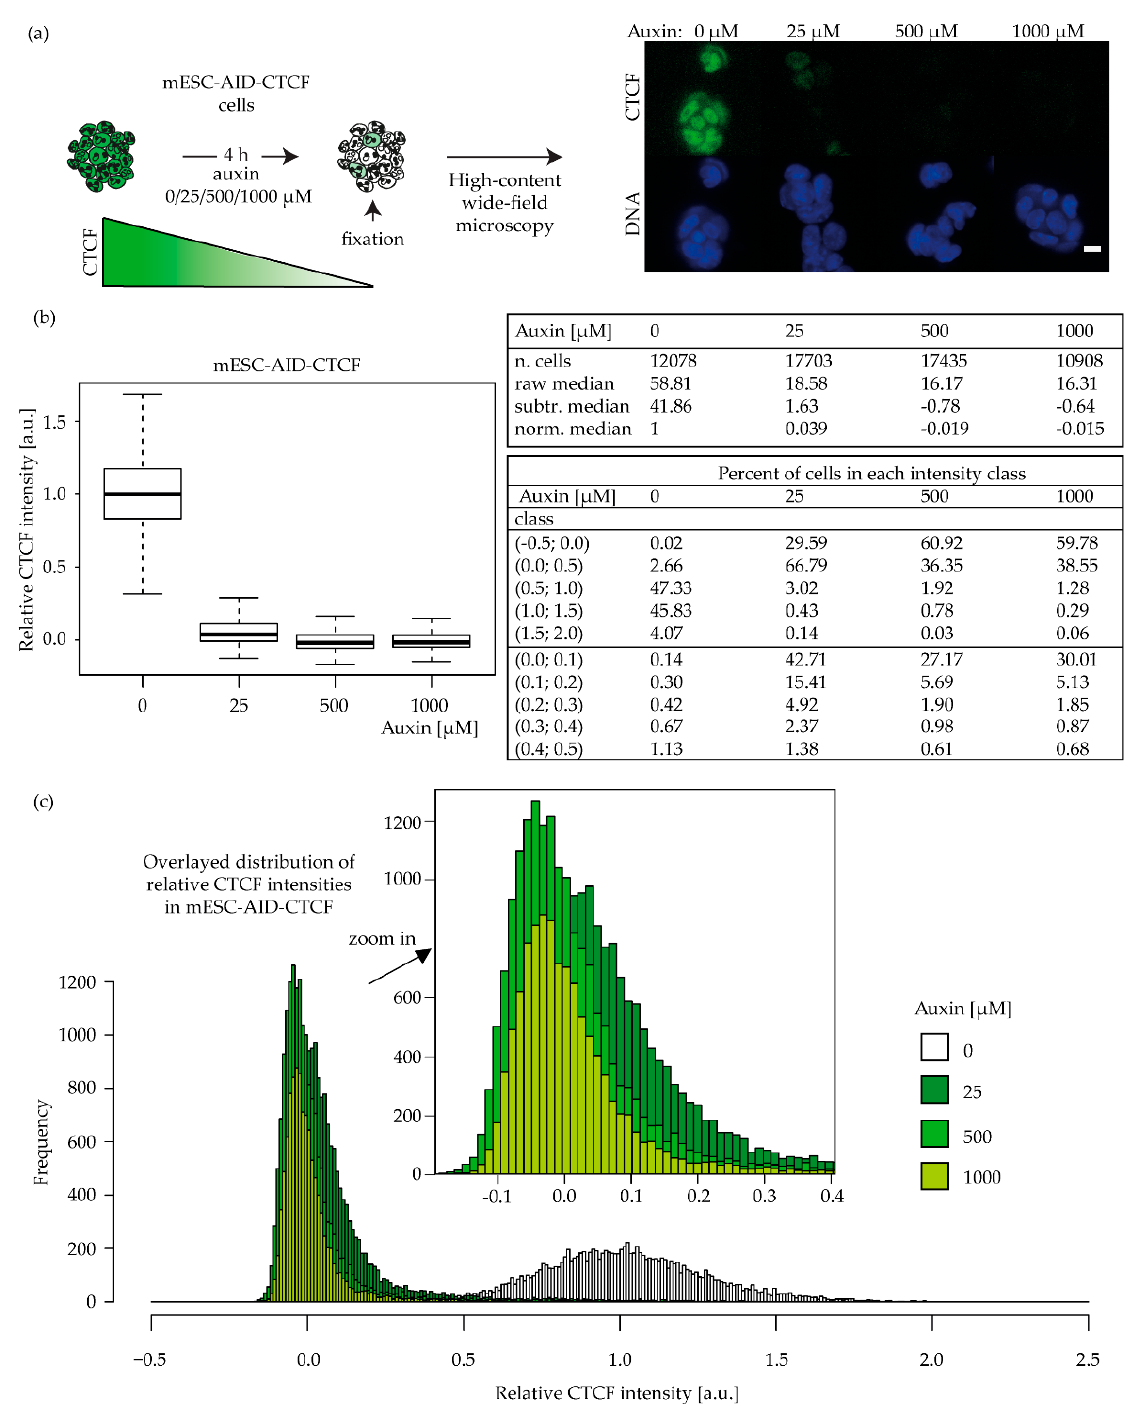
Figure 7. Degron system validation in mESC-AID-CTCF cells. ( a ) Cells were subjected to different concentrations (0, 25, 500, 1000 µM) of auxin for 4 h, fixed, and imaged using a high-content wide-field microscope (scale bar 10 µm, Figure S1, Table S3); ( b , c ) Nuclear CTCF-GFP mean intensities were measured, the background as measured in untagged mESC was subtracted, and the resulting data were normalized to the untreated control sample (0 µM); normalized CTCF values are shown as boxplots ( b ) and as frequency distributions ( c ), together with the percent of cells lying within the different classes of CTCF intensities. The results are based on four biological replicates (Table S4). See Figure S3 for the boxplot interpretation. In Figure S6, the relative kinetics of auxin-induced CTCF depletion and recovery after auxin wash-off are further investigated in a time course